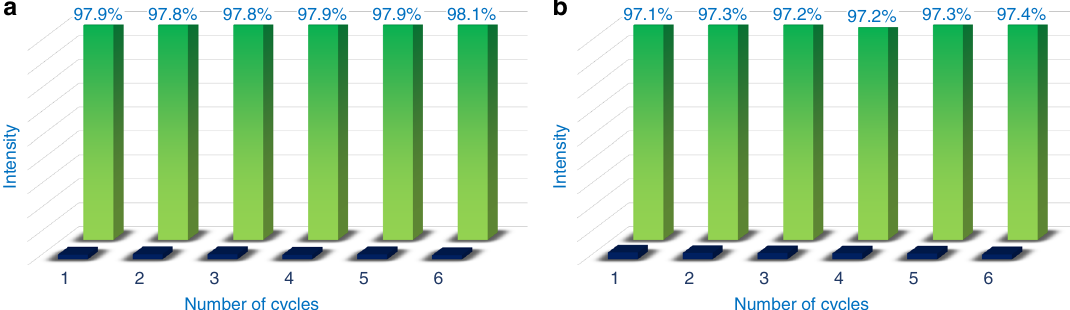
Fig. 4 Recycling experiment and stability tests. The quenching ability of Zn-MOF-C-Tb dispersed in DMF in the presence of a Cinchonine and b Cinchonidine with six cycles (the green and blue bars represent the initial luminescence intensity and the intensity with 1 mmol L − 1 analytes, respectively) at 544 nm. Numbers above the bars are the ratio of quantitative